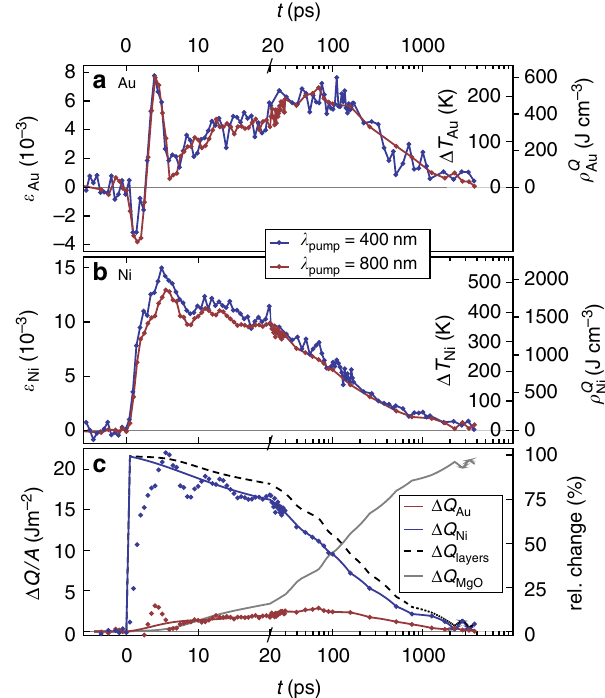
Fig. 3 Transient energy densities and temperatures. Transient lattice strain ε in the Au fi lm ( a ) and the Ni fi lm ( b ) as measured by UXRD after excitation with 400nm (blue) and 800 nm (red) light pulses. The right axis label the temperature change Δ T and the energy density ρ Q calculated from ε . c Red and blue dots show the energy per unit area Δ Q / A obtained from ( a , b ) by multiplication with d Au,Ni . The red and blue lines show thermal dynamics with acoustic oscillations removed, yielding the true energy per unit area Δ Q / A . The black dashed line shows the sum of these energies. The gray line is the thermal energy that has been transported into the